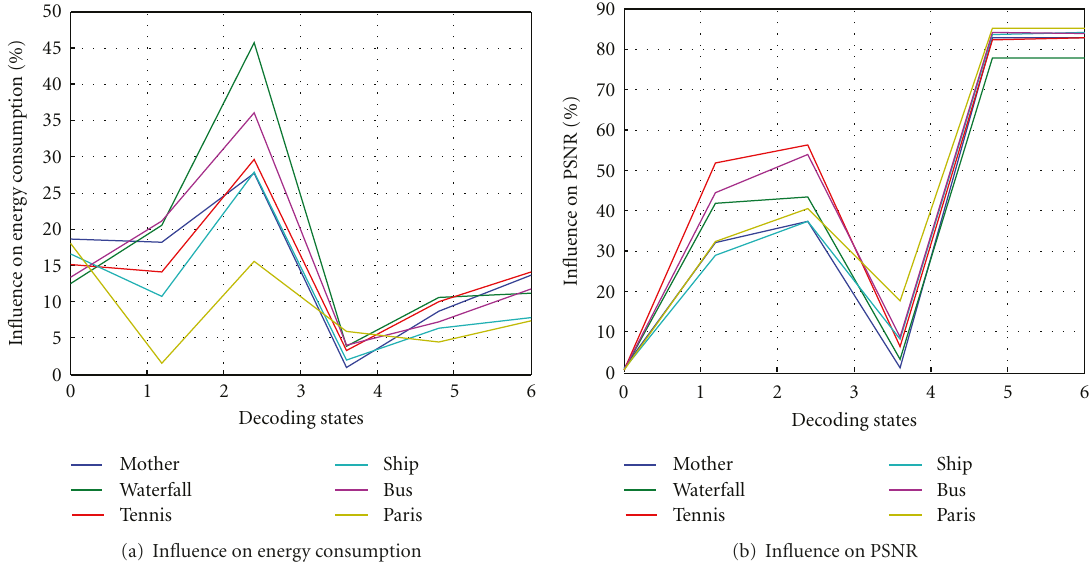
Figure 5: Influence on energy consumption and PSNR under di ff erent decoding